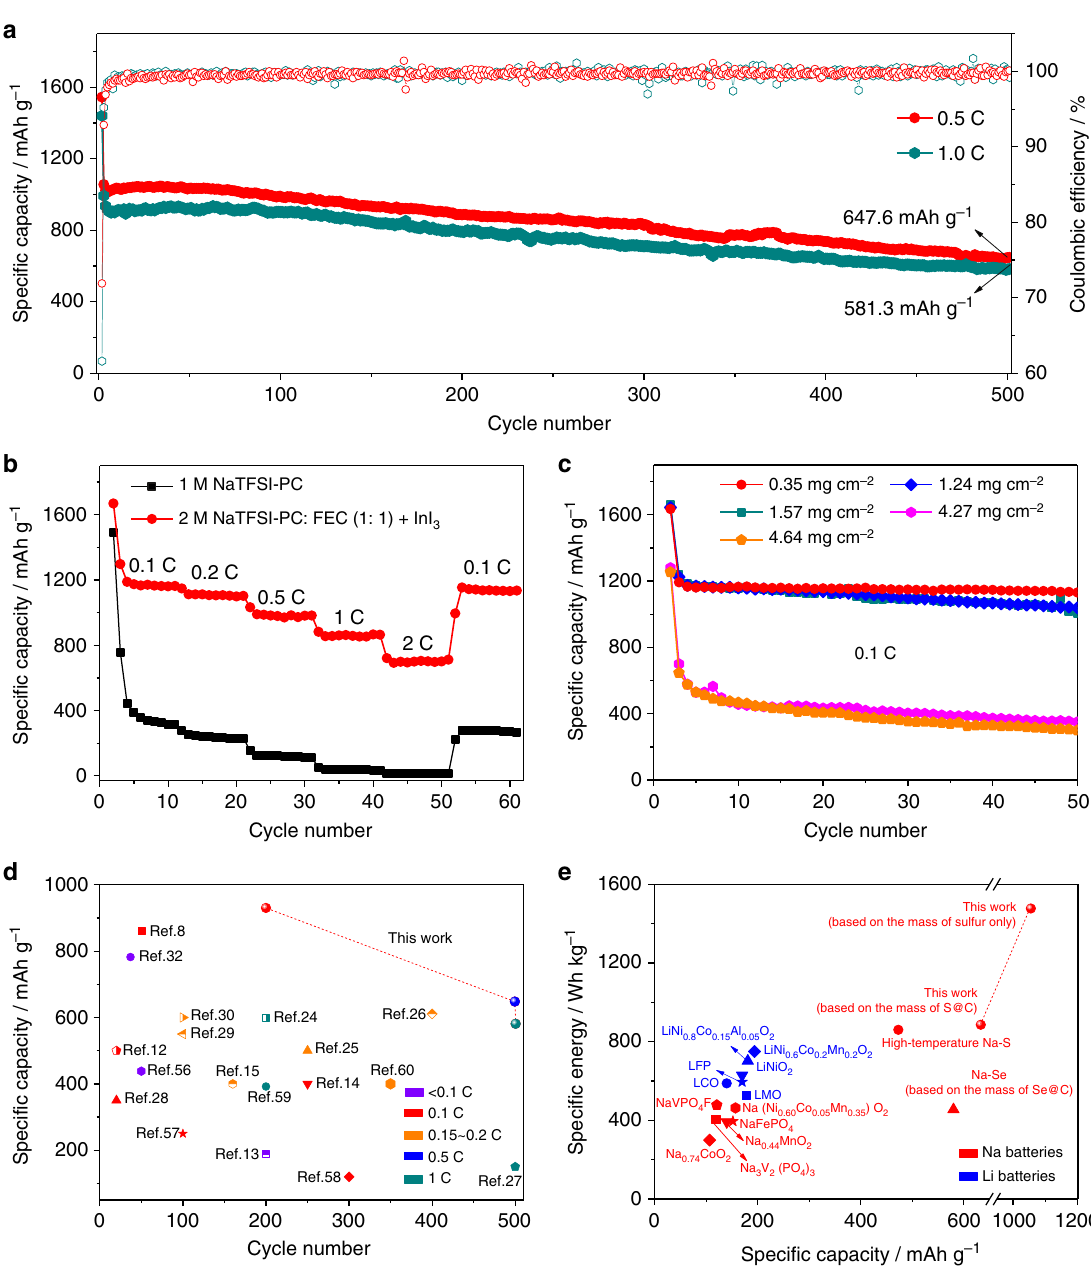
Fig. 6 Electrochemical performances of Na/2M NaTFSI in PC: FEC with 10 mM InI 3 /S@MPCF cells. a Long-term cycling performances of Na/2 M NaTFSI in PC: FEC (1: 1 by volume) with 10 mM InI 3 /S@MPCF cells at 0.5 C and 1 C; b Rate performances of Na/S@MPCF batteries using 1 M NaTFSI in PC and 2 M NaTFSI in PC: FEC with InI 3 electrolytes. The sulfur loading in Fig. 6a, b is ~0.36 mg cm − 2 ; c Cycling performances of Na/2 M NaTFSI in PC: FEC